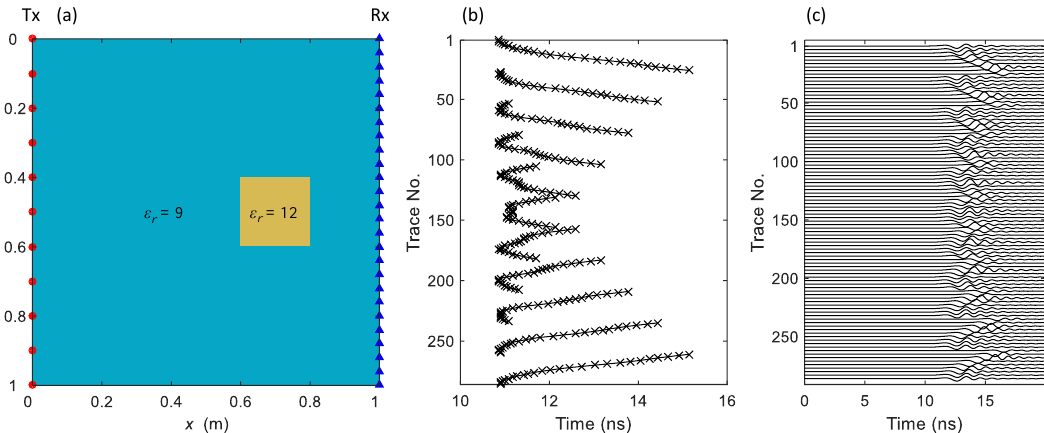
Figure 1. ( a ) Reference relative permittivity ( ε r ) model, ( b ) synthetic first-arrival traveltime data, and ( c ) waveform data. The red dots and blue triangles denote the positions of crosshole ground penetrating radar (GPR) transmitters and receivers,